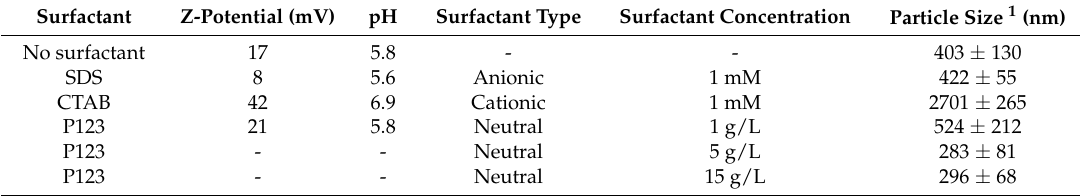
Table 2. Influence of different surfactants in the dimensions of {[Cu 2 ( μ 3 -adeninato) 2 ( μ -Hadip) 2 ]} n . Surfactant